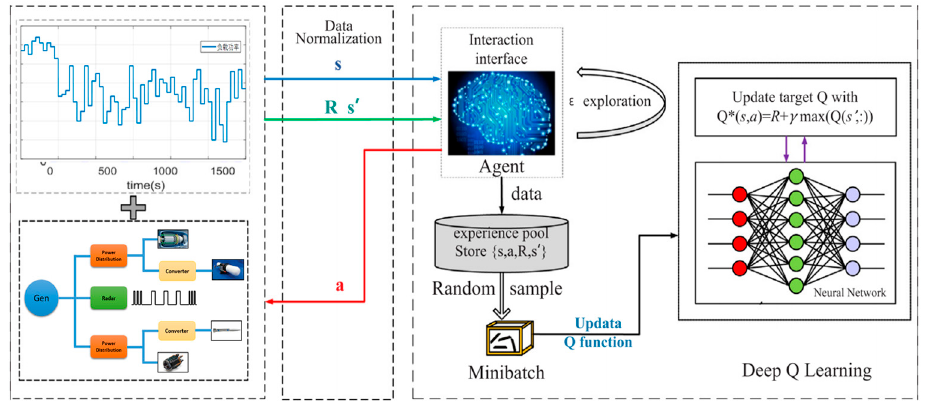
Figure 17. The control loop for the exergy based optimal energy management system for large power pulse load of aircraft.